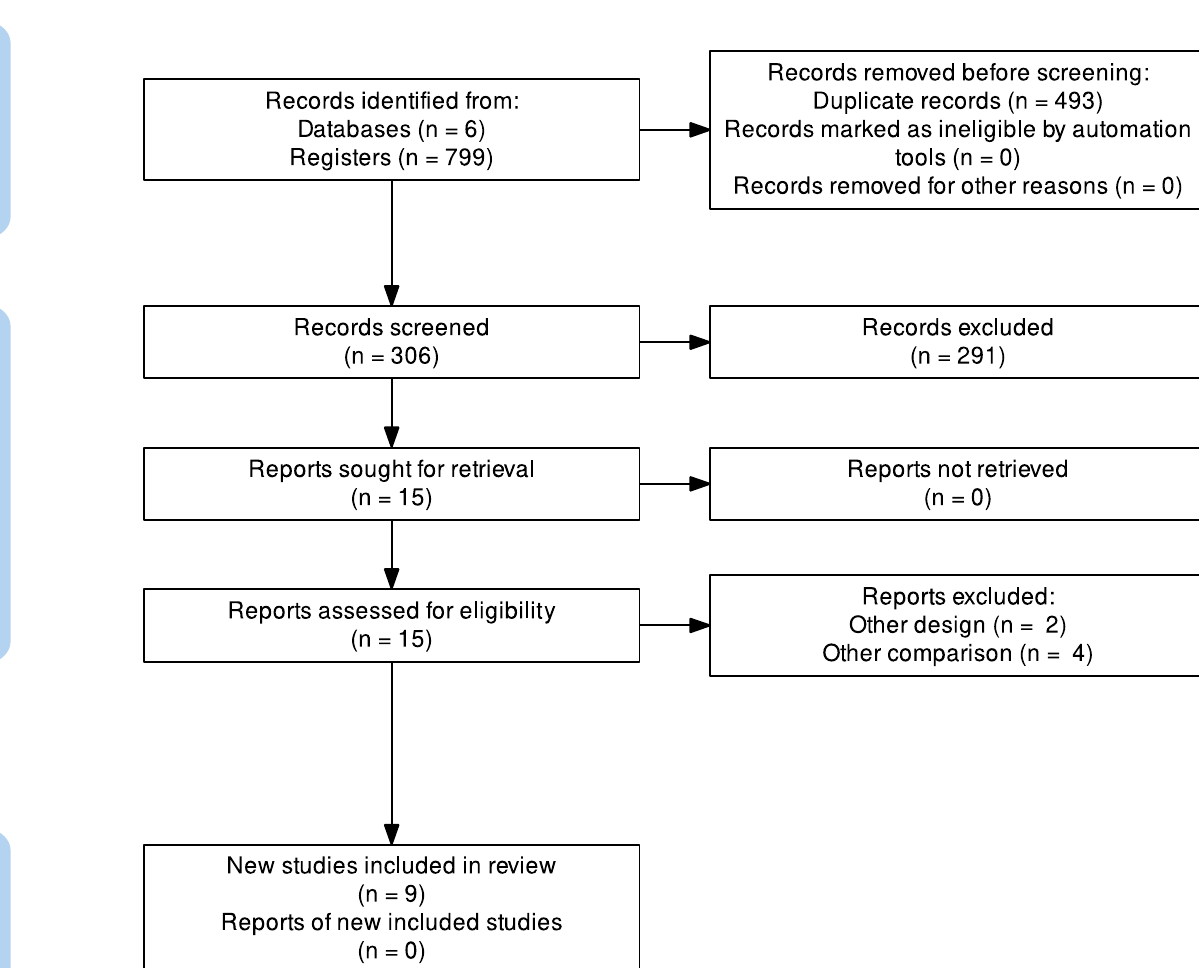
Figure 1. PRISMA flow chart of the studies selection process.